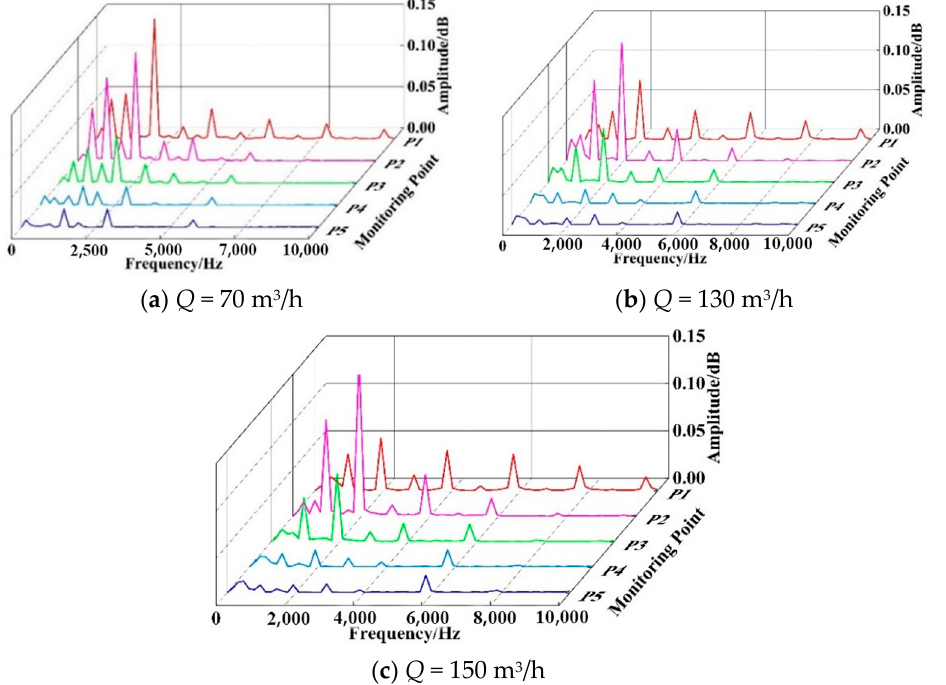
Figure 9. Frequency domain diagram of pressure fluctuations at monitoring points in the guide vane flow channel.